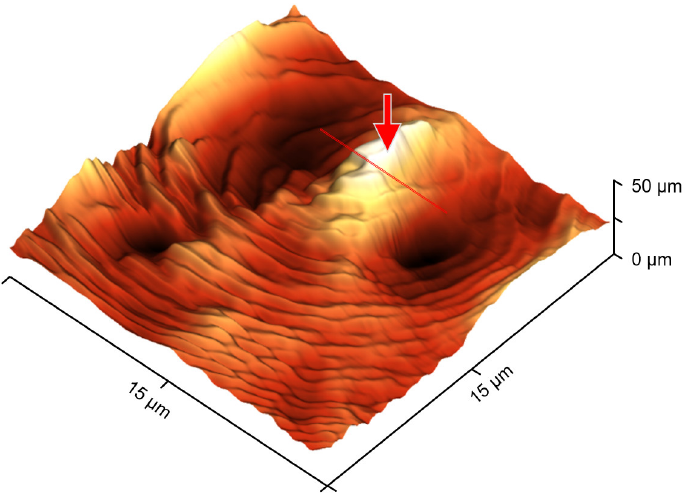
Figure 4. Pseudo 3D-AFM height image of PCL after isothermal crystallization at 330 K for 3600 s (scanning time 3000 to 4200 s).